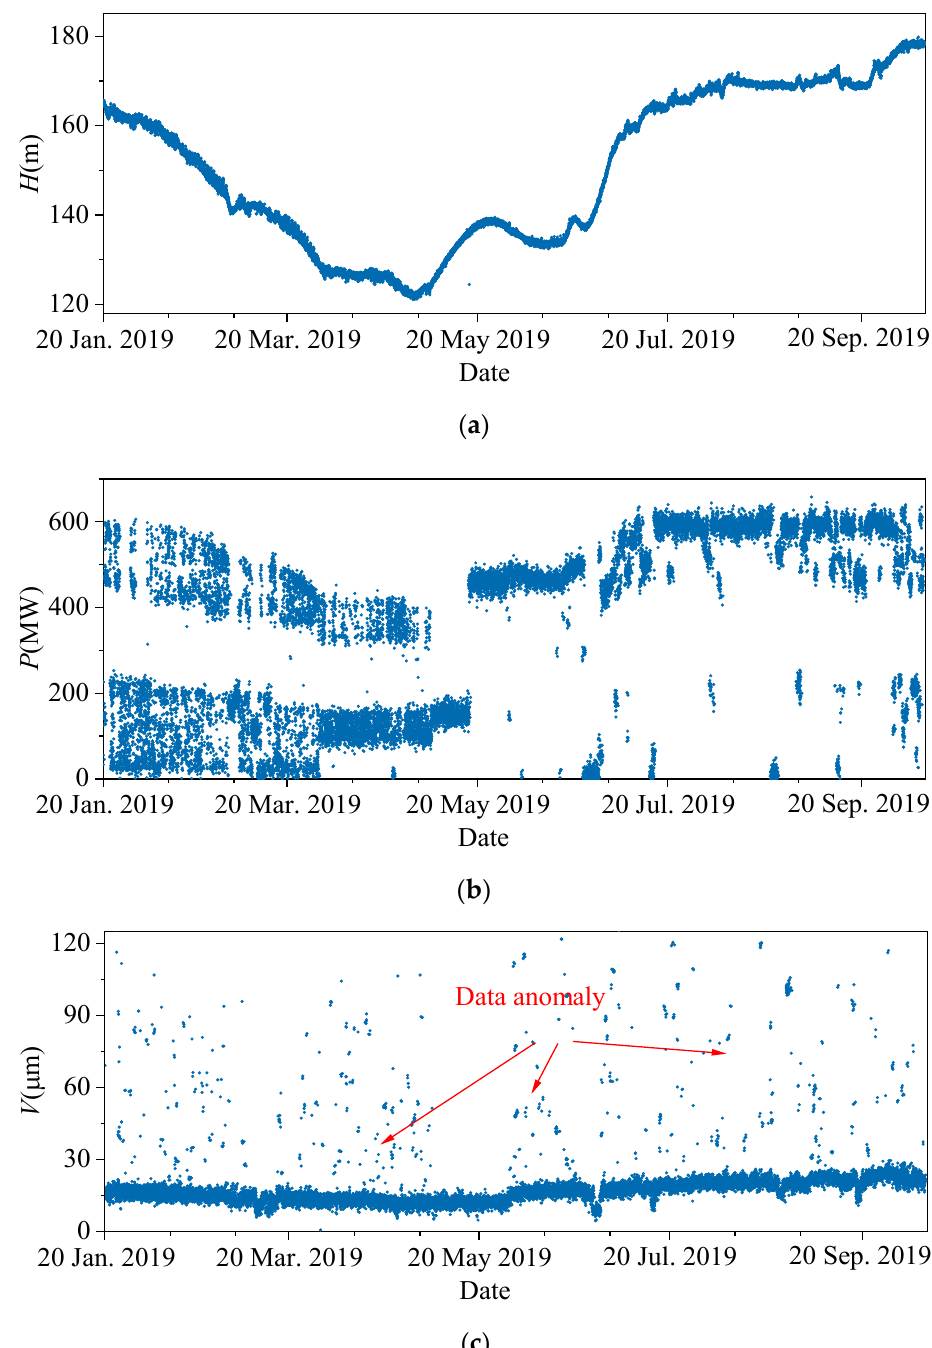
Figure 8. On-site raw data: ( a ) water head H ; ( b ) active power P ; and ( c ) vibration amplitude of the top cover V .